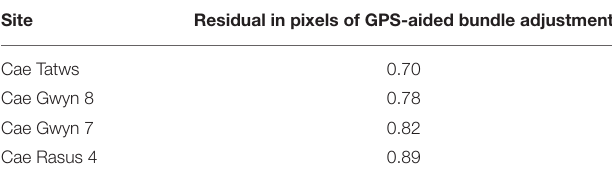
TABLE 3 | Bundle adjustment RMSE for each dataset (in